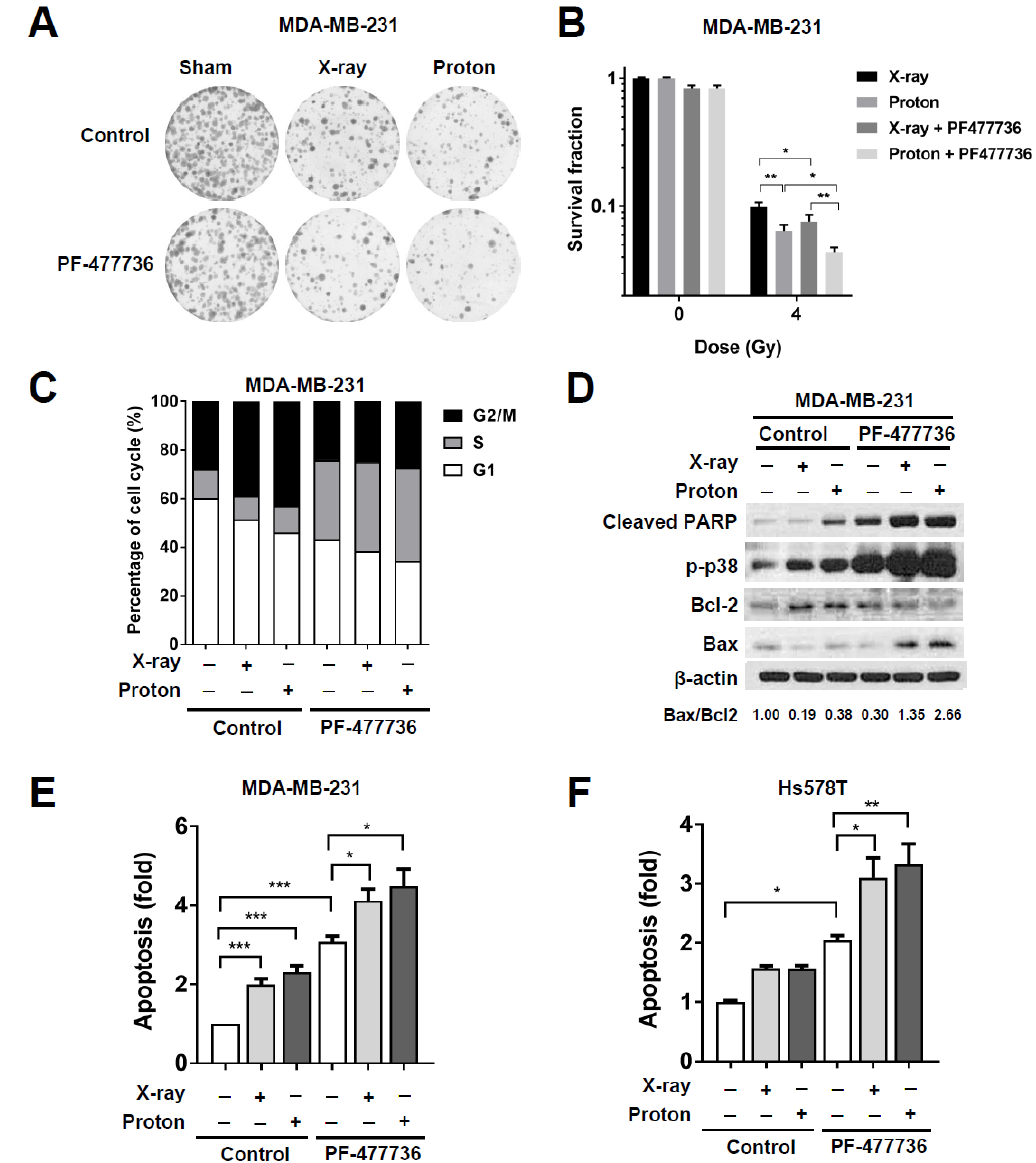
Figure 3. CHK1 inhibition in response to PF-477736 treatment sensitizes TNBC cells to proton irradiation. ( A ) Effect of co-treatment with PF-477736 and 4 Gy of X-rays or protons on clonogenic survival. MDA-MB-231 cells were pre-treated with 100 nM PF-477736 for 3 h, followed by irradiation with 4 Gy of X-rays or protons. Colonies were stained with crystal violet after 14 days; ( B ) Quantification of survived colonies. Data are shown as mean ± S.D. from two independent experiments. * p < 0.05; ** p < 0.01; ( C ) Cell-cycle distribution after combinatorial treatment with PF- 477736 and X-rays or protons. MDA-MB-231 cells pre-treated with 500 nM PF-477746 for 3 h were